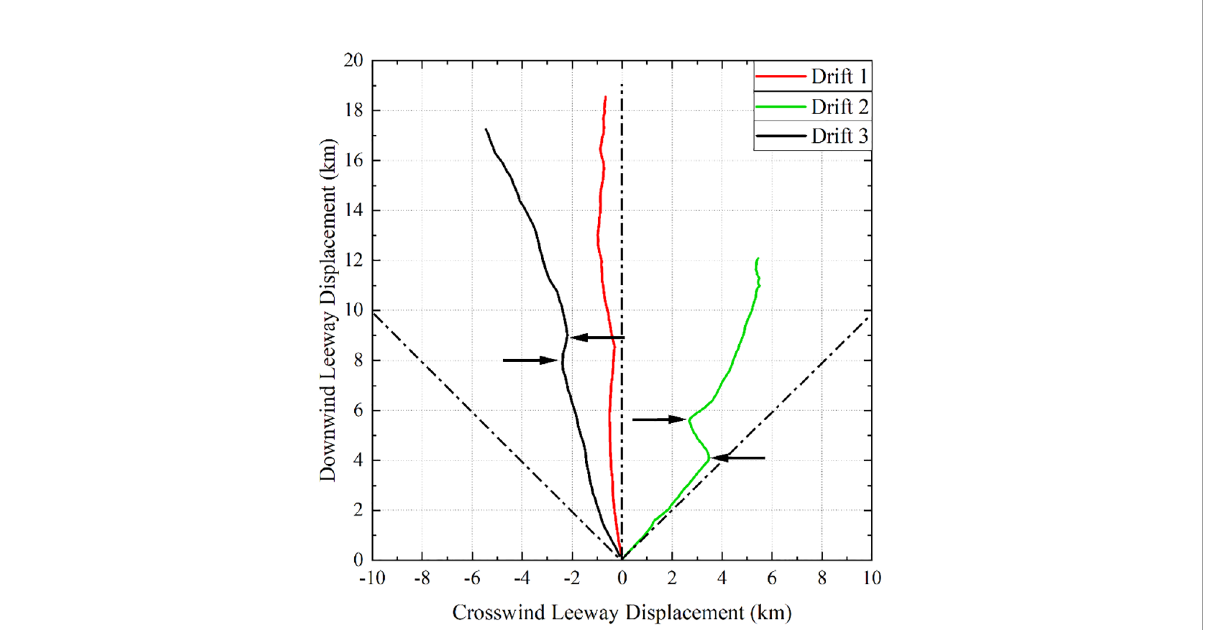
FIGURE 7 Leeway displacement for the open lifeboat as depicted in a progressive vector diagram (PVD) for the downwind and crosswind components. Black arrows represent jibing